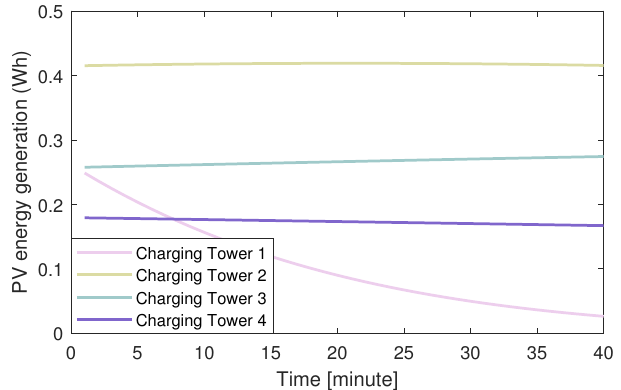
Figure 2. Photovoltaic power generation distributions in individual charging